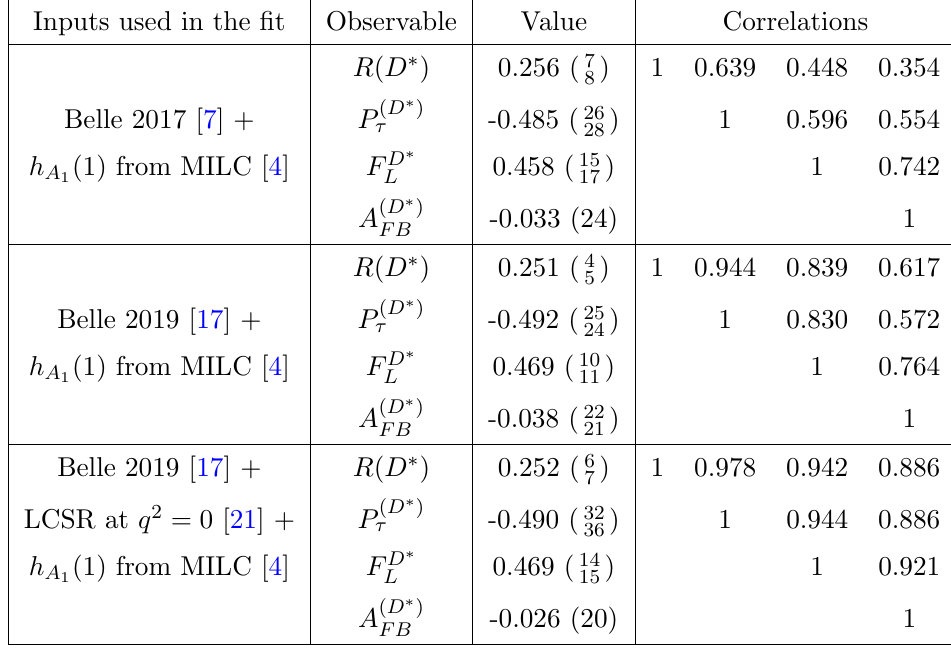
Table 6. SM predictions for and the correlations between the observables in B ! D (cid:3) (cid:28)(cid:23) (cid:28) decays as obtained from di(cid:11)erent (cid:12)t scenarios for N = 2. The estimates corresponding to the 2017 Belle data correspond to the analysis in our earlier work